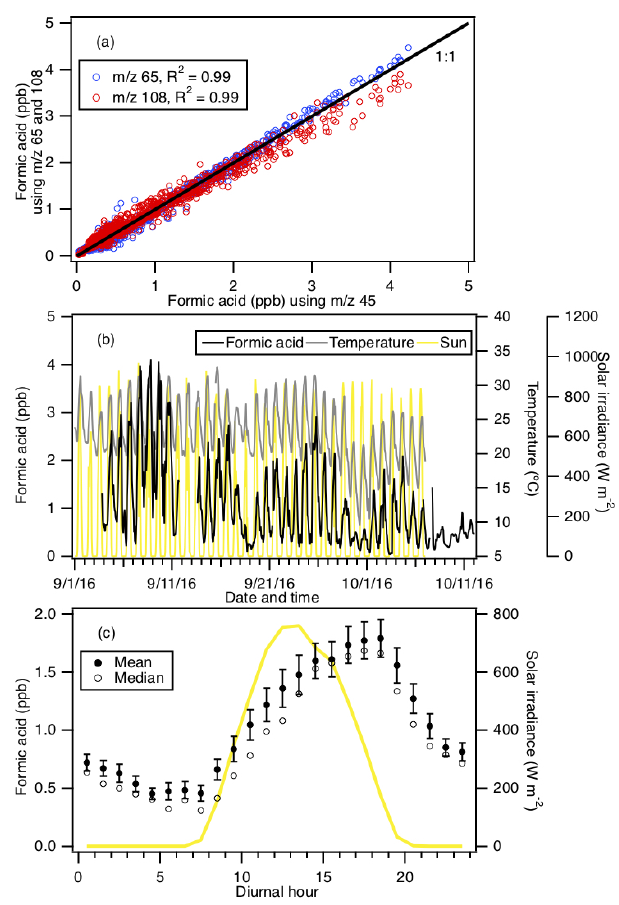
Figure 3. (a) Scatter plot comparison of ambient formic acid con- centrations determined using mass peaks m/z 45, 65 and 108. The three datasets correlated well with one another ( R 2 = 0 . 99). Lin- ear regression of the data gave slopes of 1 (for m/z 65) and 0.95 (for m/z 108), indicating that all three mass peaks can be used to determine the formic acid concentration. (b) Time series of formic acid concentration, temperature and solar irradiance. All the data are displayed as 1h averages. (c) Diurnal profiles of formic acid concentration (symbols) and solar irradiance (yellow line). All the concentrations represent averages in 1h intervals and the standard errors are plotted as error